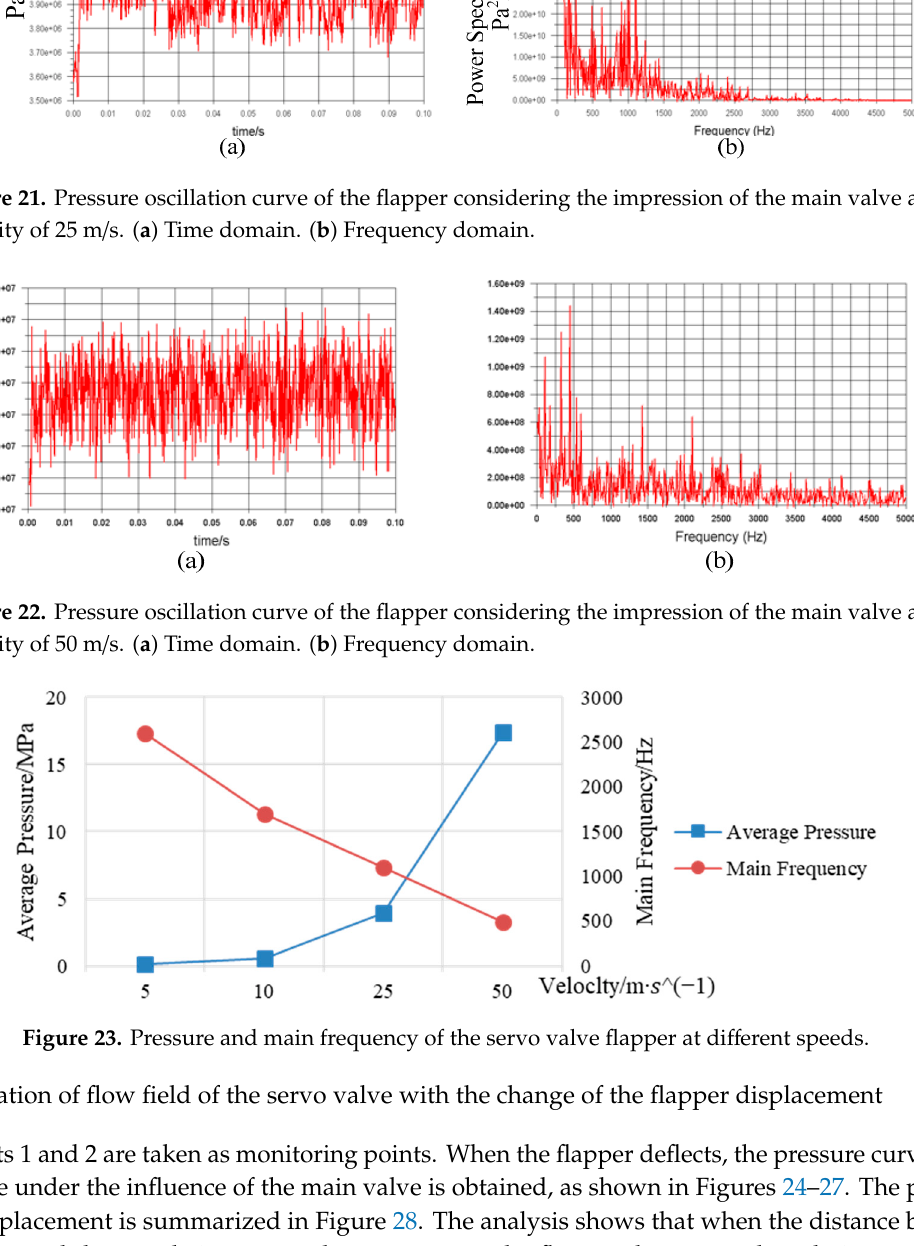
Figure 20. Pressure oscillation curve of the flapper considering the impression of the main valve and velocity of 10 m/s. ( a ) Time domain. ( b ) Frequency domain.